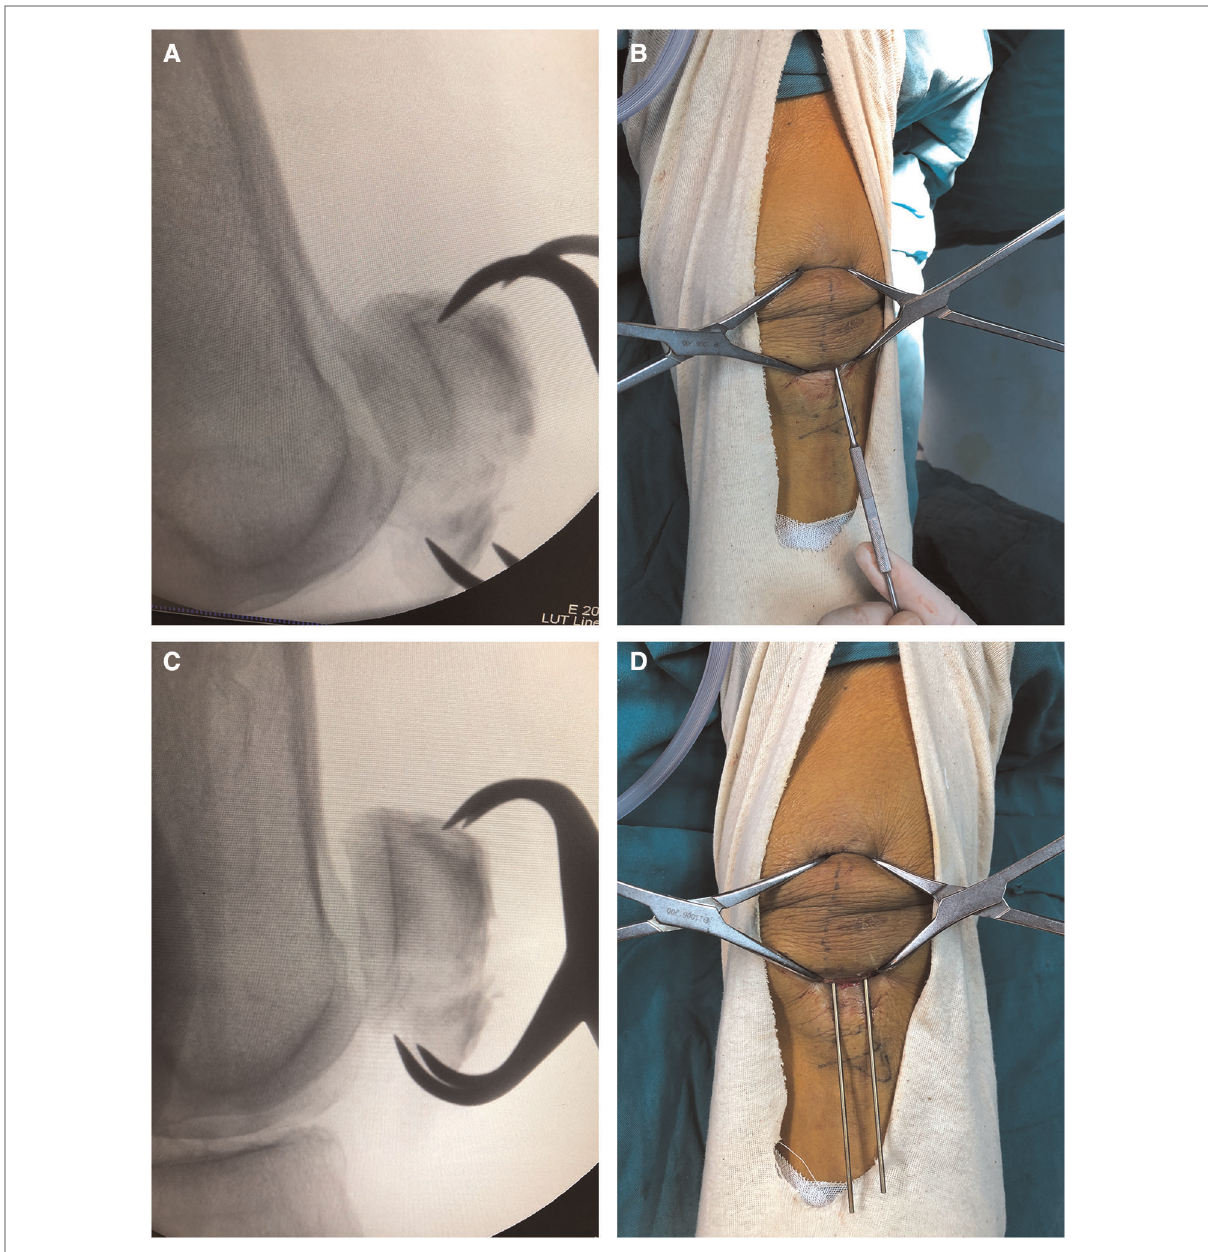
FIGURE 2 Joint application of periosteal elevator and pointed bone forceps helps achieve bone fracture reduction. ( A ) Radiograph taken after the initial reduction procedure reveals that fracture reduction was not achieved as the articular step-off still presented. ( B ) Photograph shows that a small periosteal elevator is passed through the patellar tendon to reach the articular surface of the distal bone fragments and elevate it, and then, two- pointed bone forceps were utilized to close the fracture gap. ( C ) Radiograph taken after the reduction procedure con fi rmed that the fracture was reduced. ( D ) Photograph shows two k-wires passing through the fracture to maintain the fracture